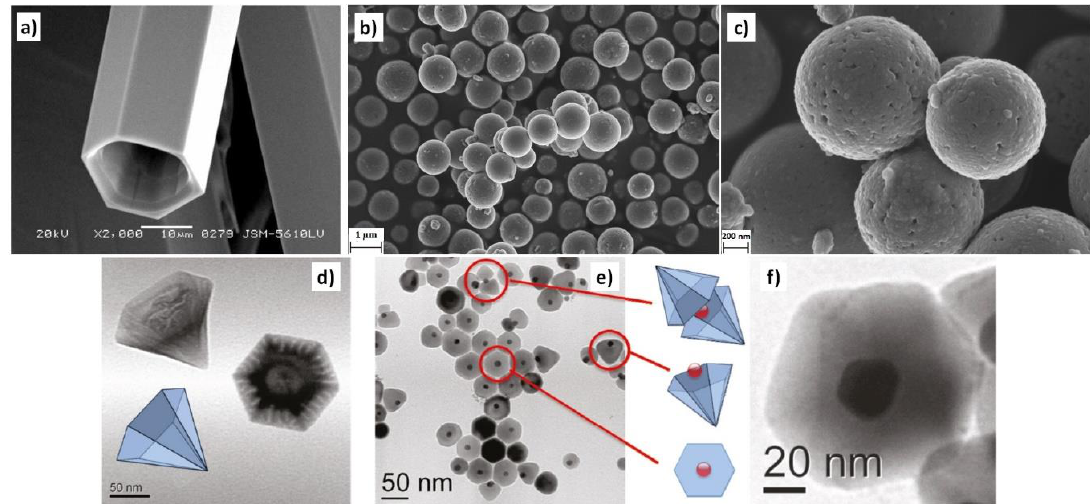
Figure 42. ( a ) SEM image of ZnO tubes (Reprinted from [868], Copyright (2005), with permission from Elsevier [OR APPLICABLE SOCIETY COPYRIGHT OWNER]); ( b , c ) SEM images of spherical Gd doped ZnO particles (own test results); ( d – f ) TEM images of Au-ZnO nanopyramids (Reprinted (adapted) with permission from [807]. Copyright © 2011, American Chemical Society). ( a , d – f ) All rights reserved. In order to re-use permission must be obtained from the rightsholder.